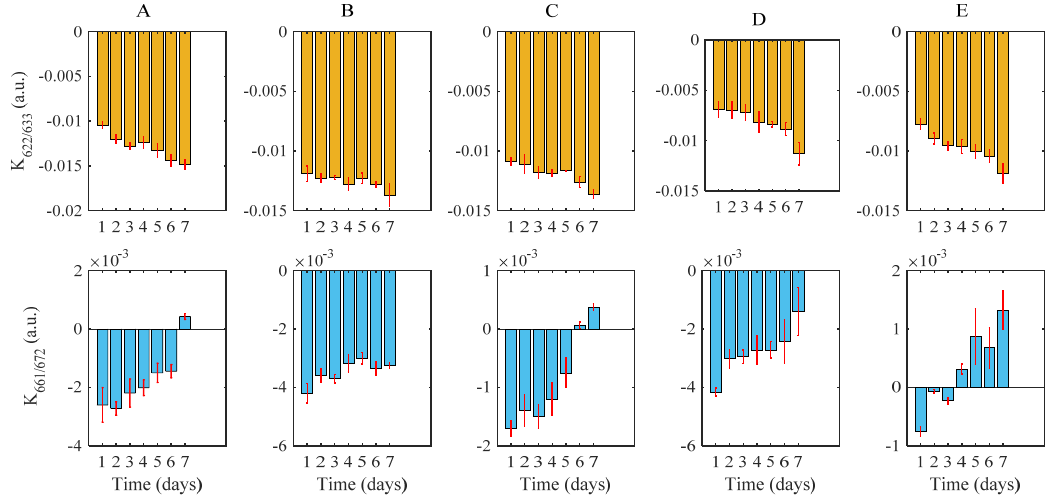
Figure 4. K 622/633 and K 661/672 values calculated for yogurt samples (A, B, C, D, and E) over one week.